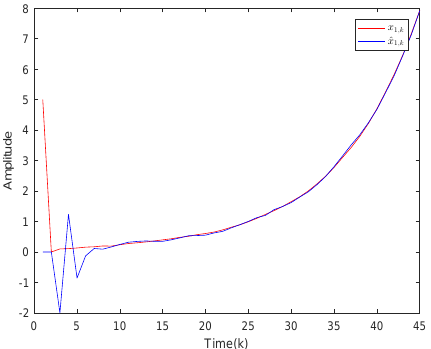
Figure 2. The state evolutions of x 1, k and corresponding estimates ˆ x 1, k .